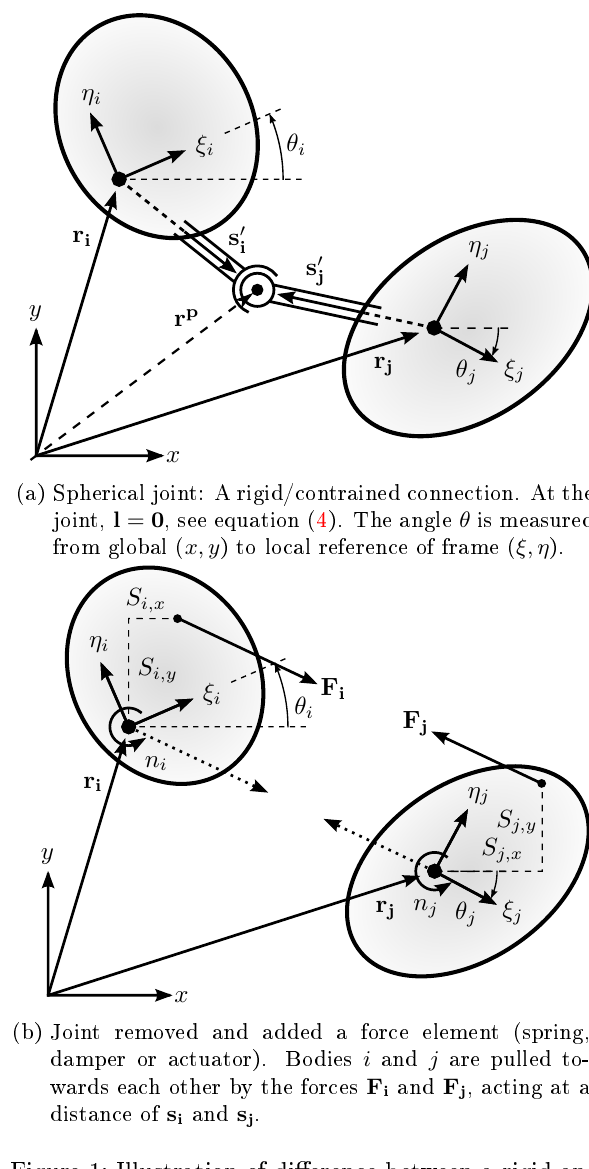
Figure 1: Illustration of di(cid:27)erence between a rigid and a (cid:29)exible connection for bodies i and j